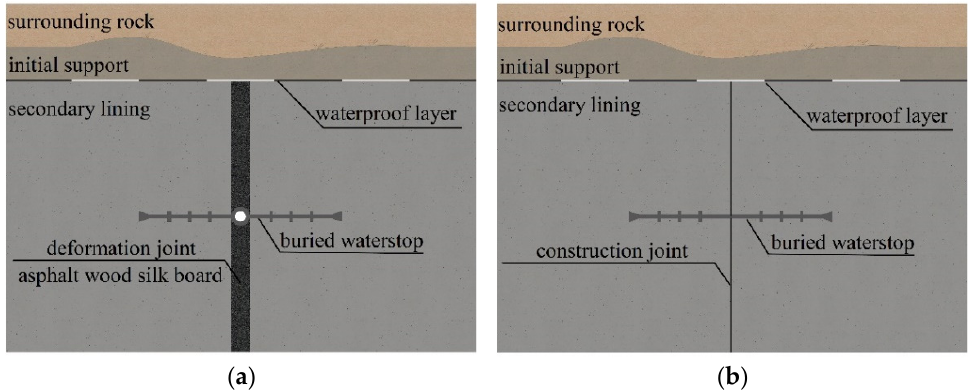
Figure 1. Schematic diagram of the waterproof structure of the mountain tunnel joints. ( a ) Deformation joint, ( b ) Construction joint.